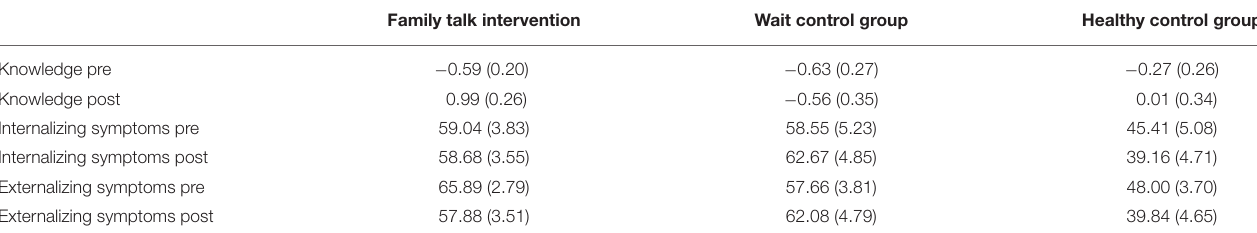
TABLE 2 | Means and standard deviations (SD) for pre-post knowledge and parent rated internalizing/externalizing symptoms for the three different groups. Family talk